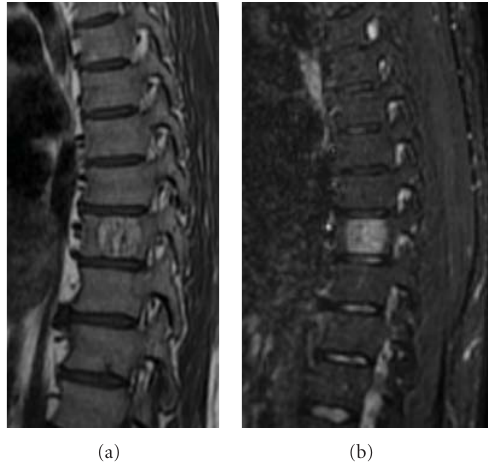
Figure 15: Sagittal T1-weighted (a) and STIR (b) MR images depict a well-circumscribed lesion in a mid thoracic vertebral body. The hyperintense signal and linear hypointensities, which correspond to thickened trabeculae, are characteristic of a benign